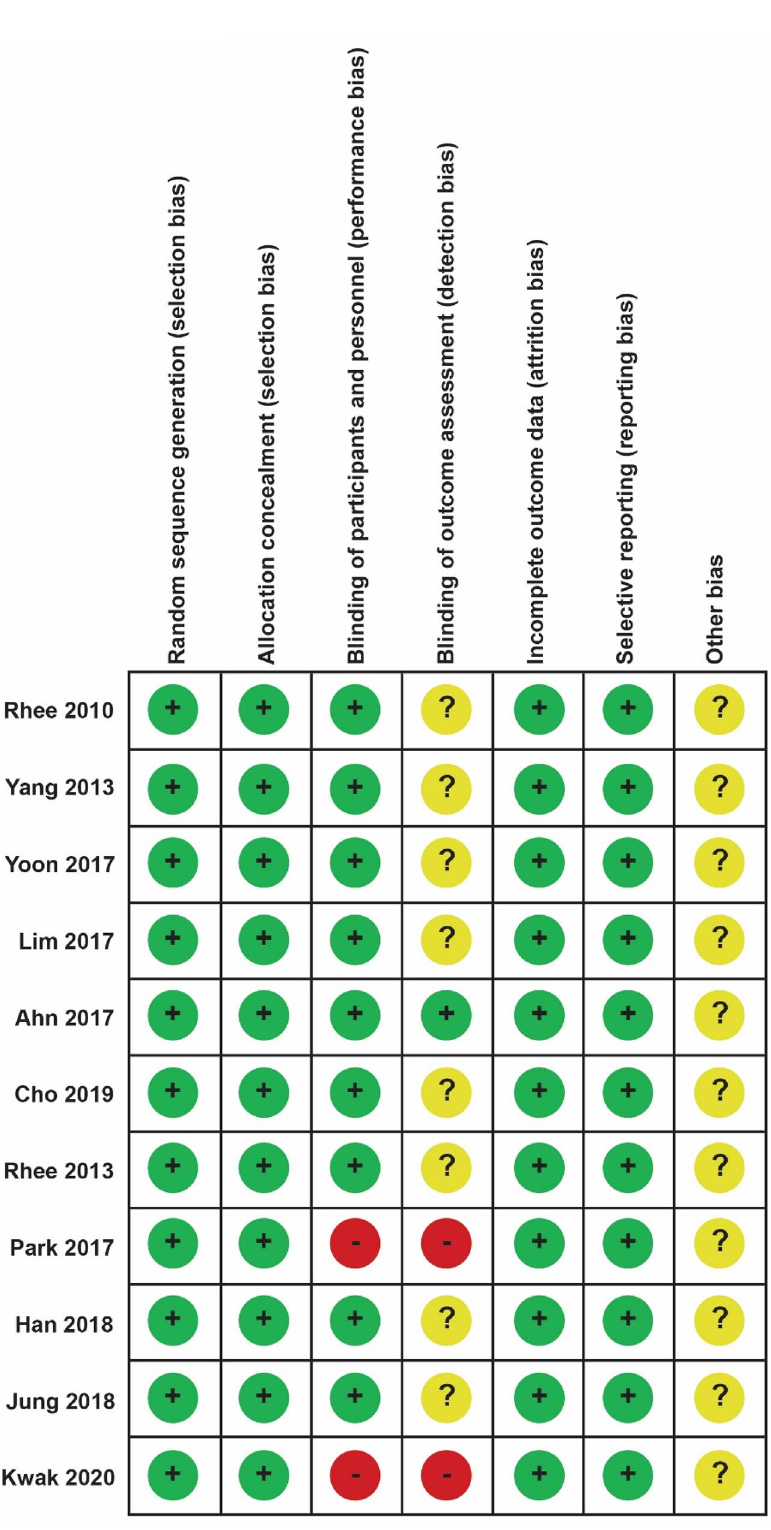
Figure 3. Quality assessment of the risk of bias of the eleven selected